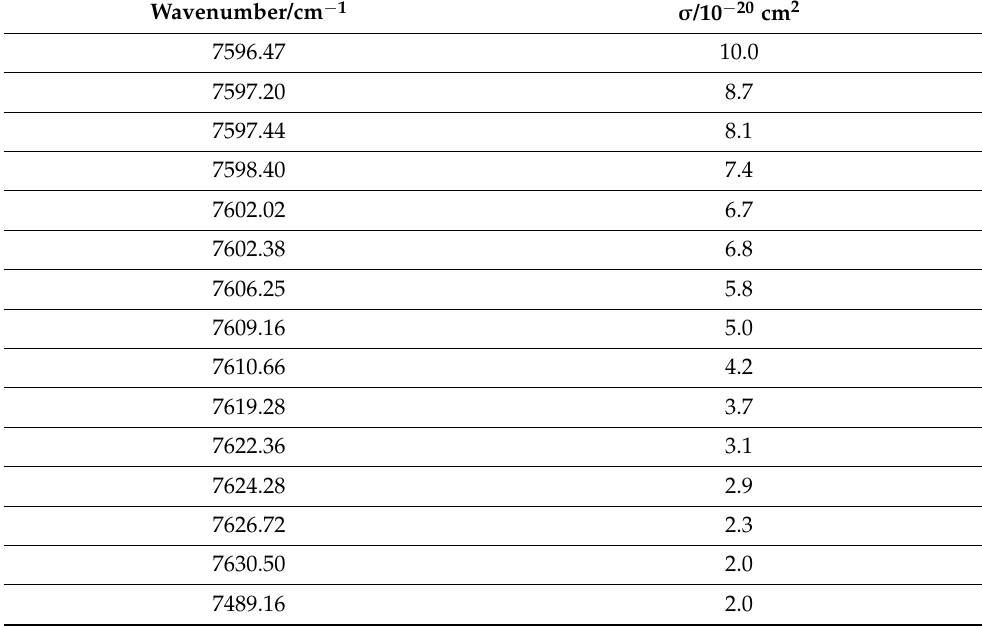
Table 4. C 2 H 5 O 2 Absorption cross-sections at different